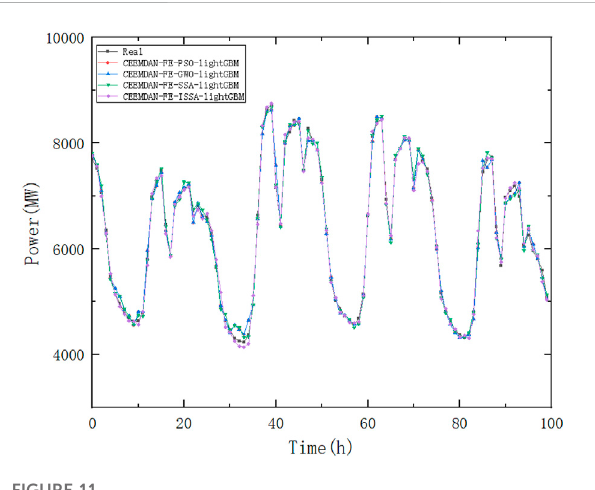
FIGURE 9 Prediction results of Case 1.